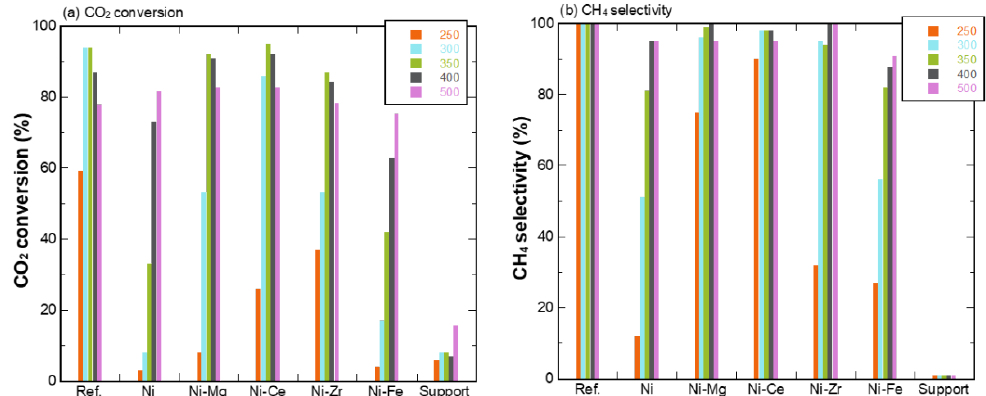
Figure 3. Temperature dependence of promoter-doped Ni/Eco catalysts for CO 2 methanation. ( a ) CO 2 conversion and ( b ) CH 4 selectivity (Flow rate 3.6 cc/min, WHSV = 8700 mL/h/g, 73% H 2 , 18% CO 2 , and 9% Ar ).